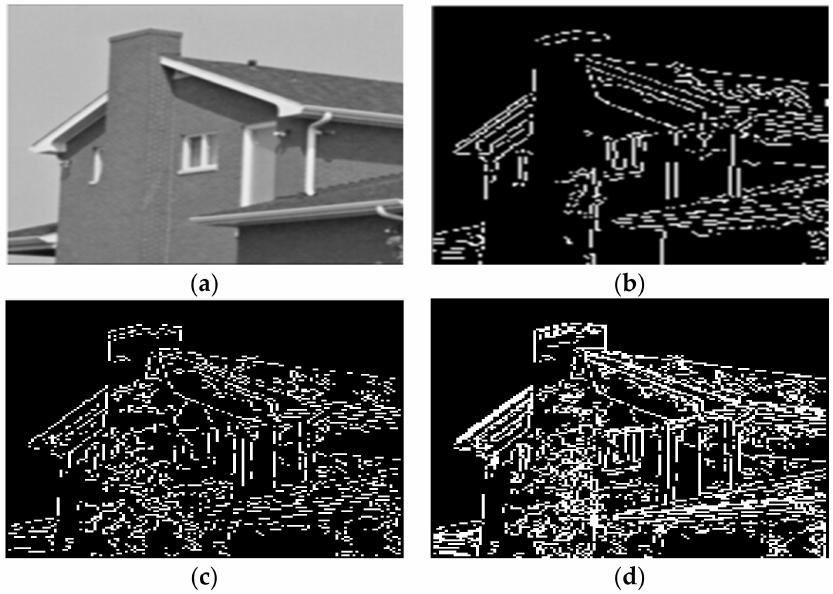
Figure 10. Segmentation results of House by different algorithms. ( a ) The original image. ( b ) The water division lines were obtained by the algorithm in this paper. ( c ) The water division lines were obtained by the algorithm in [11]. ( d ) The water division lines were obtained by the algorithm in